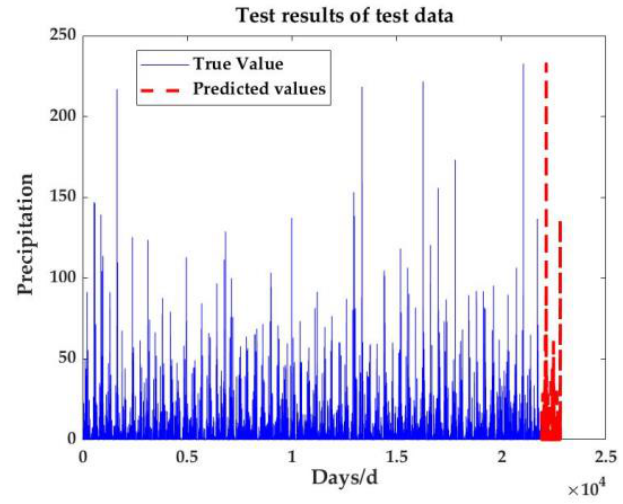
Figure 7. Combined graph of test and predicted data.